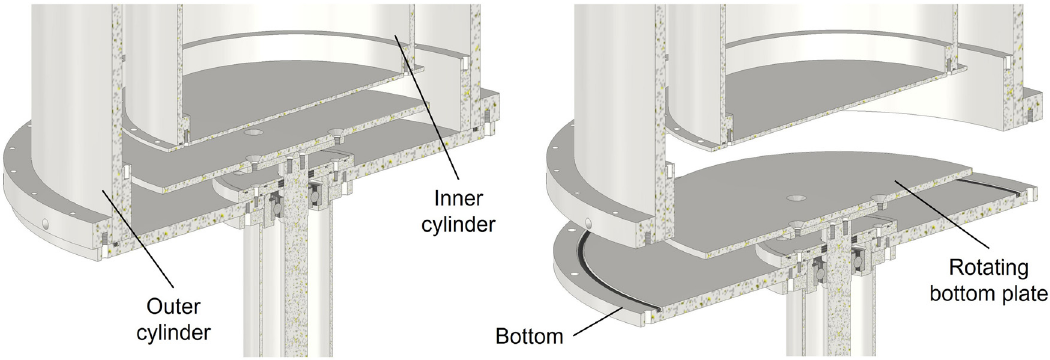
Figure 2: Sectional view to illustrate the emptying of rheometer by moving the bottom unit, closed on the left, and opened on the